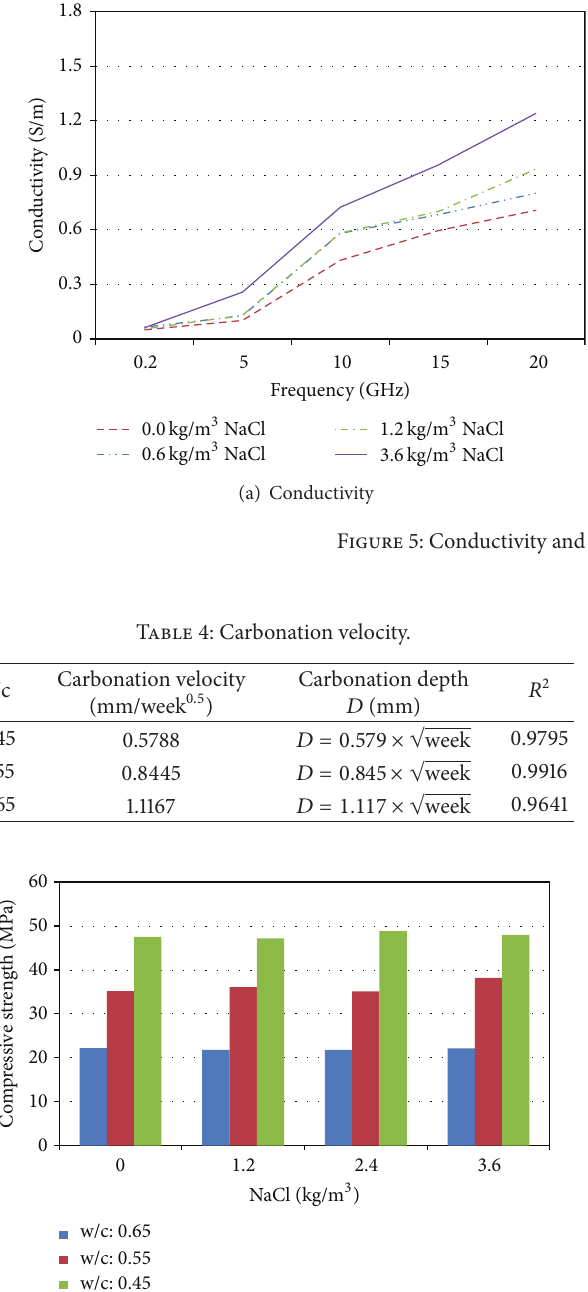
Figure 6: Compressive strength with different chloride contents.